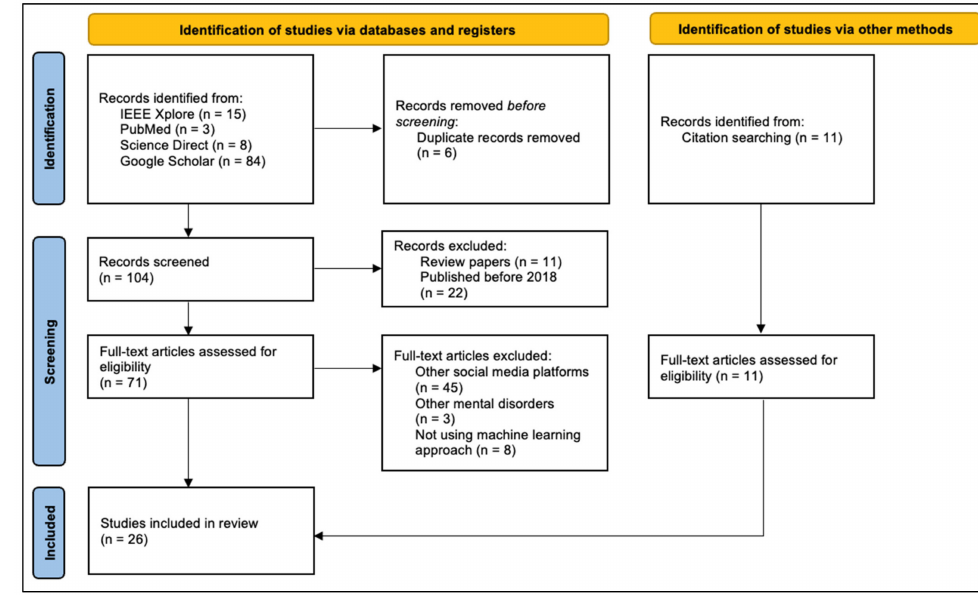
Figure 1. Study selection flowchart based on PRISMA